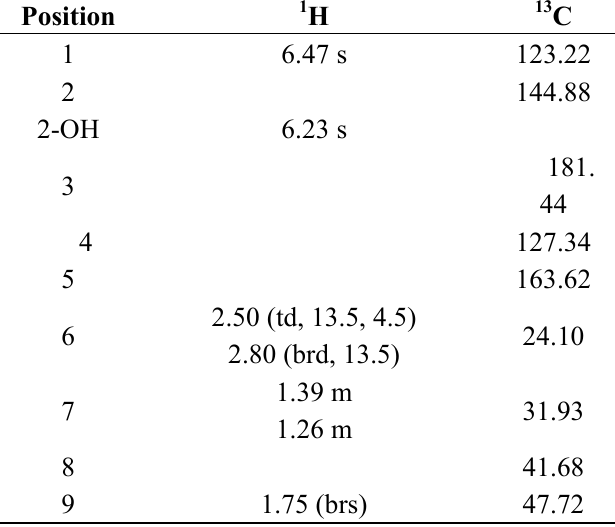
(500 MHz for 1 H-NMR and 125 MHz for 13 3